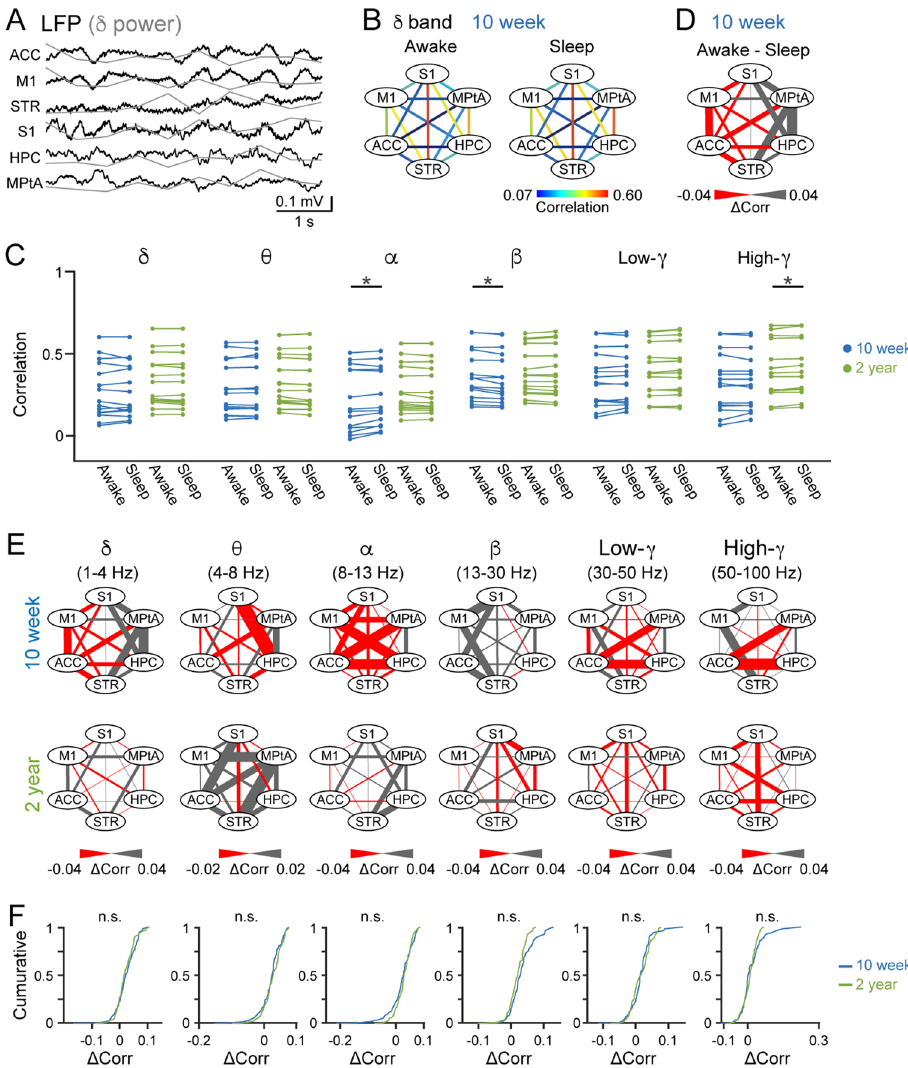
Figure 2. Interregional correlations of LFP power changes across awake/sleep states in young and aged mice . ( A ) LFP signals were converted into normalized delta power (superimposed as gray lines) every 1 s. ( B ) Representative color-coded maps showing correlation coefficients of delta power changes for 15 pairs of the six brain regions. Data are from a representative 10-week mouse. ( C ) Comparisons of averaged correlational power changes in six frequency bands between awake and sleep states. Each line represents each brain region pair. * P < 0.05, Wilcoxon signed-rank test followed by Bonferroni correction. ( D ) A color-coded map showing differences in the power correlations (Δcorr) between awake and sleep states, constructed from B. ( E ) Color- coded maps showing Δcorr in awake and sleep states in six frequency bands. Data are averaged from all mice. ( F ) Cumulative distributions of Δcorr. P > 0.05, Mann–Whitney U test. MATLAB R2021b (https:// jp. mathw orks. com/ produ cts/ new_ produ cts/ relea se202 1b. html) and Illustrator 26.2.1 (https:// www. adobe. com/ jp/ produ cts/ illus trator. html) were used to create this